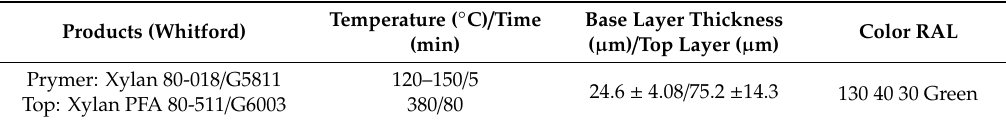
Table 1. Application process, thickness, and color of PFA TF-77530 coating.